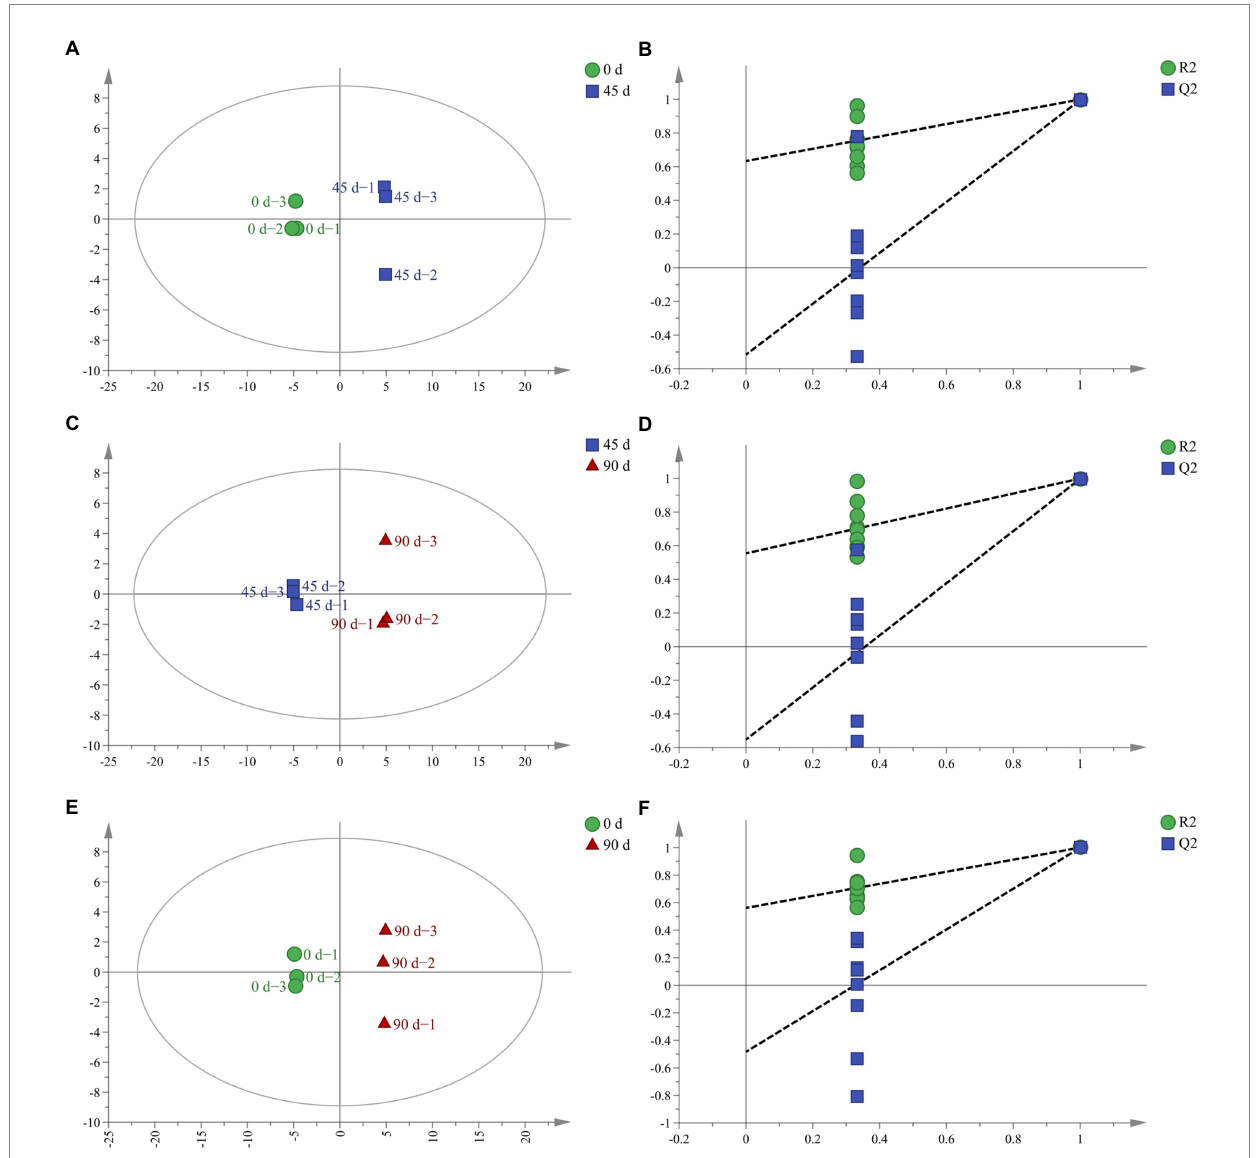
FIGURE 2 The OPLS − DA score and permutation test for LSCKs fermented for 0, 45, and 90 days. (A,C,E) Respectively, indicates the OPLS − DA analyses for A1 (0–45 days), A2 (45–90 days), and A3 (0–90 days); (B,D,F) , respectively, represents permutation tests for A1 (0–45 days), A2 (45–90 days), and A3 (0– 90 days).